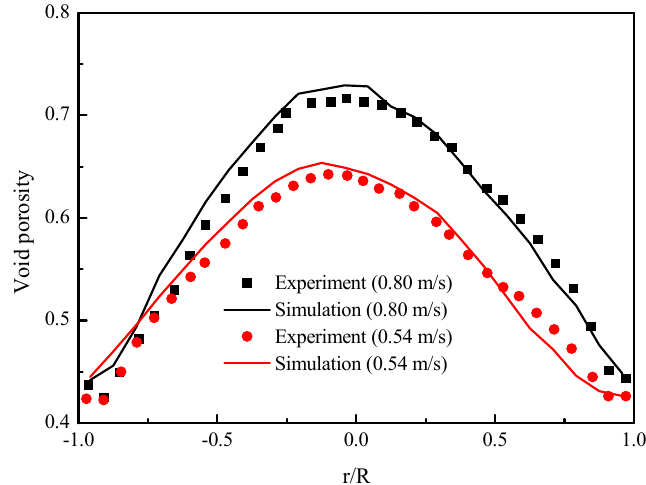
Figure 9. The time-average void porosity along the radial direction at the axial height 0.143–0.181